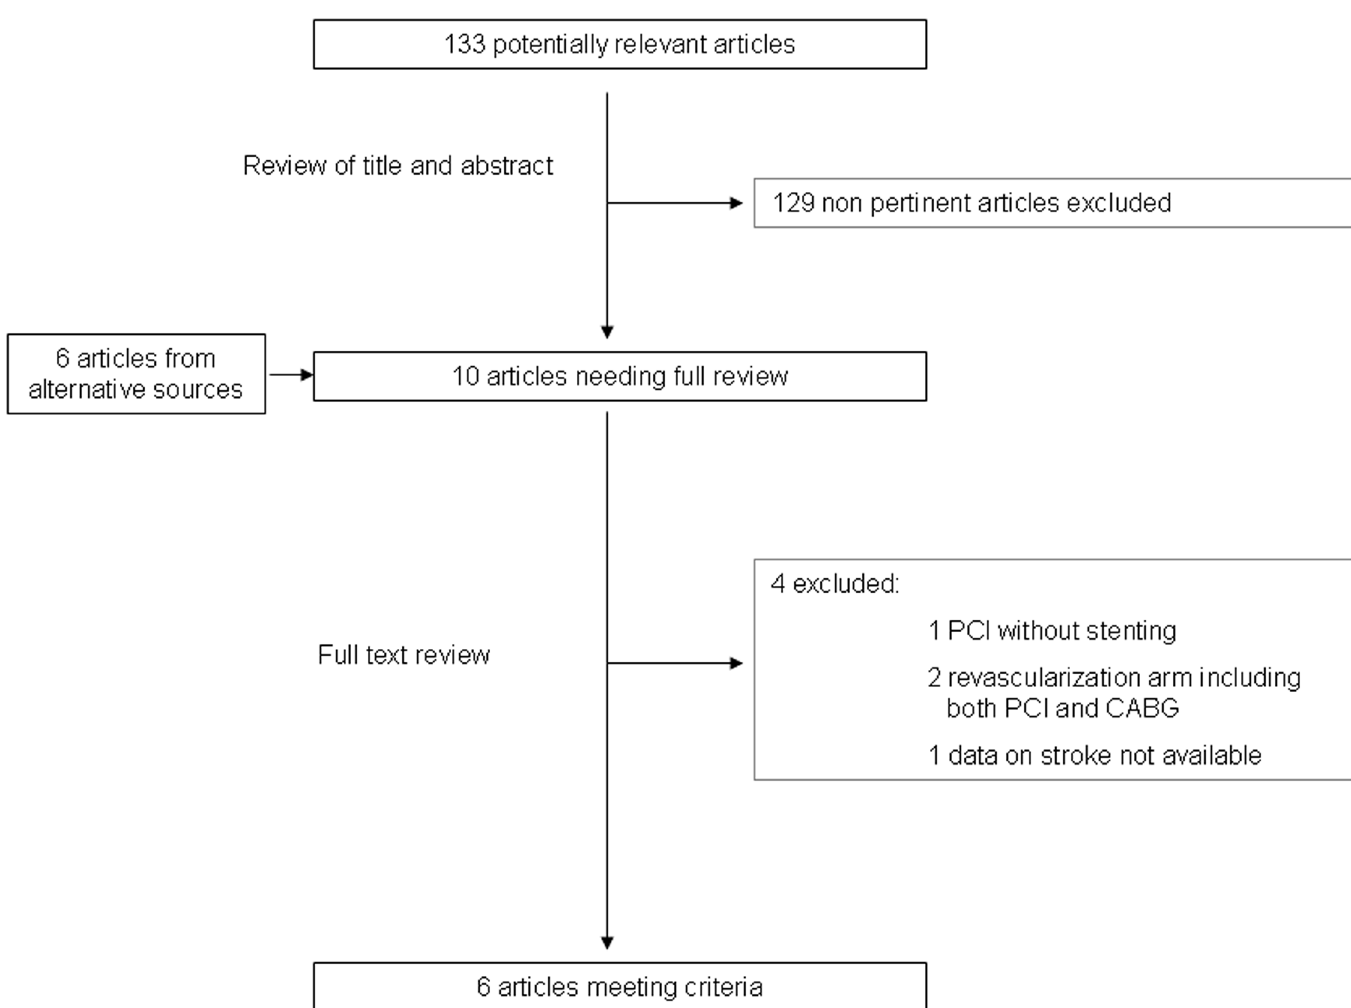
Fig 1. Study flow chart. Abbreviations: CABG = coronary artery bypass grafting; PCI = percutaneous coronary intervention.